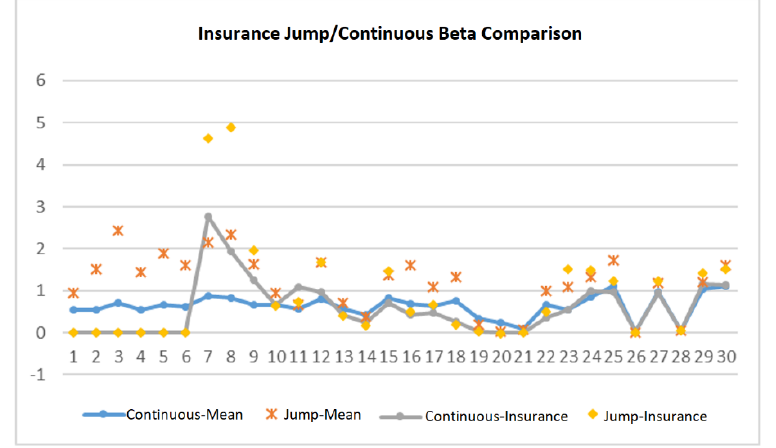
Figure 2: Comparison of Insurance jump/continuous betas with industries averages